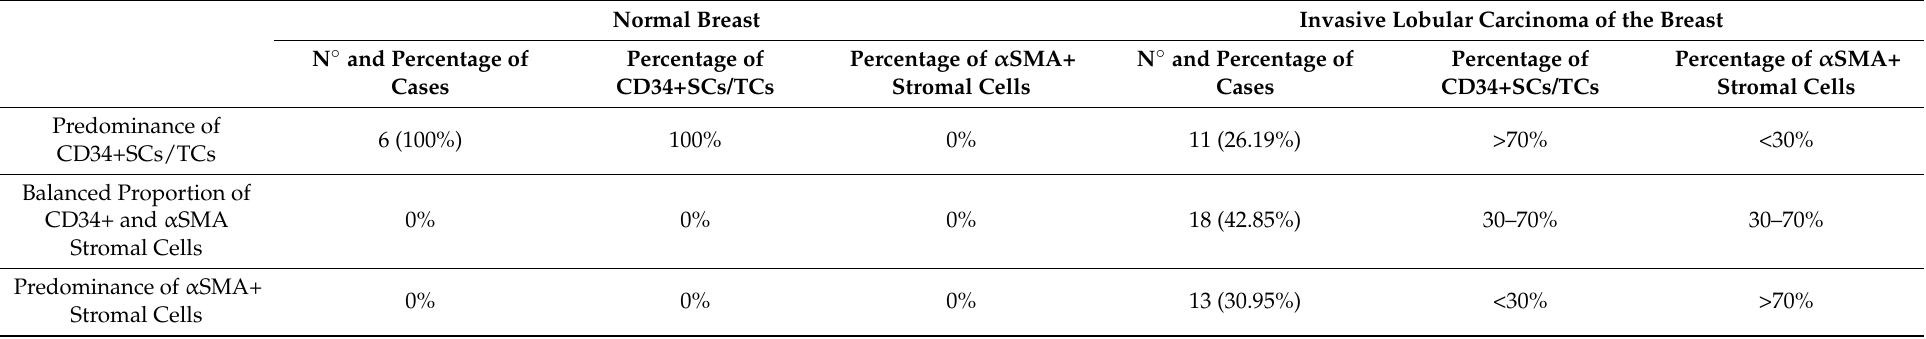
Table 1. Numbers and percentage of cases, and percentage of stromal cells expressing CD34 and α SMA in normal breast (control cases: 6) and in tumor stroma of invasive